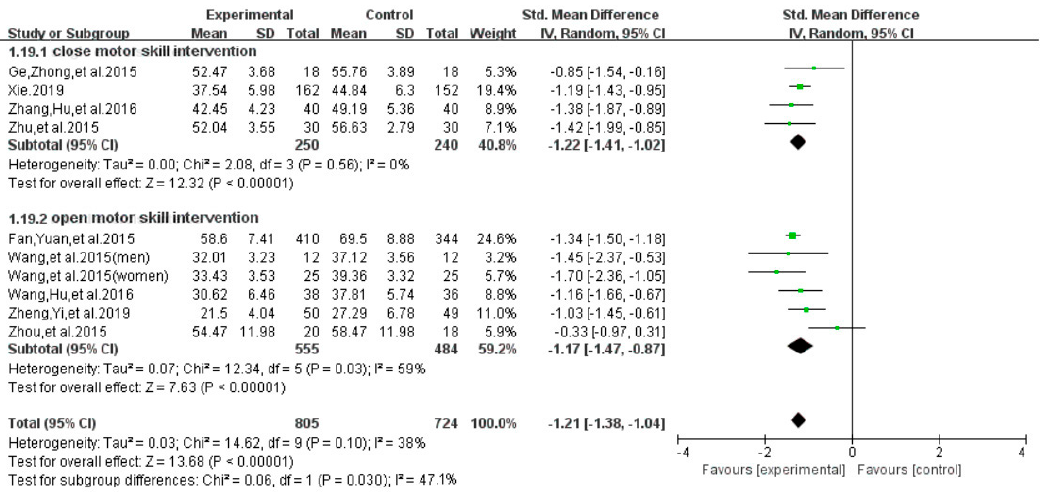
Figure 14. E ff ect of di ff erent exercise interventions on smartphone